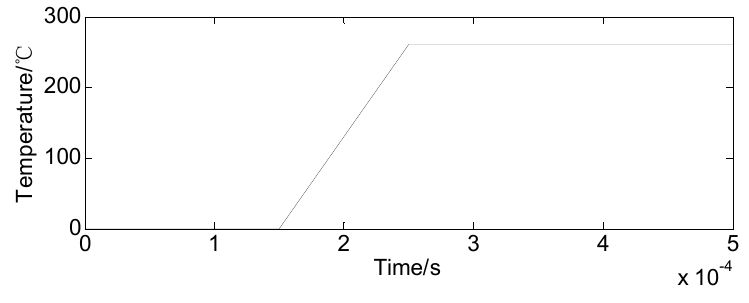
Figure 13. The temperature-time curve.